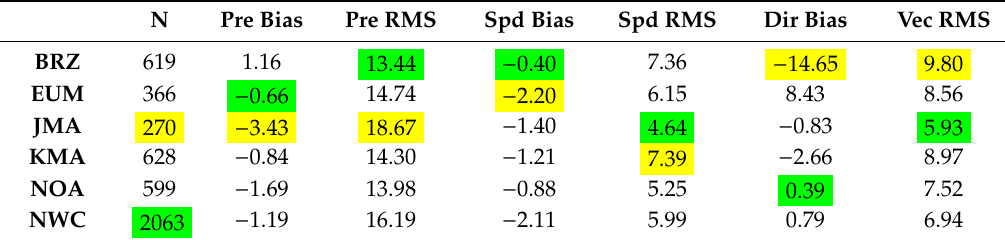
Table 12. The same as Table 11, but with Common Quality indicator (CQI) >= 80%.